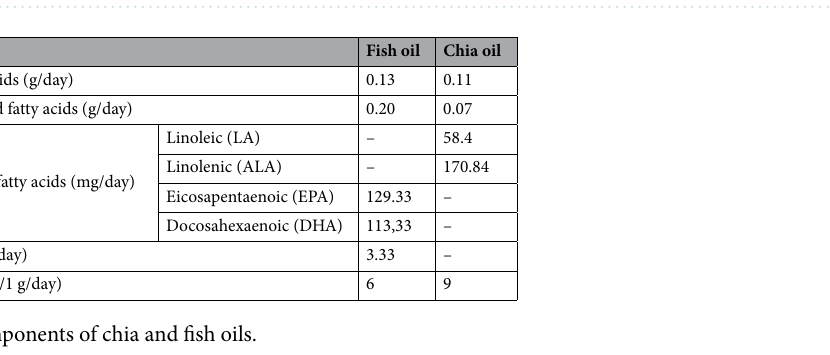
Figure 9. Timeline of intervention protocol for 14 weeks of a high-fat diet, fish oil supplementation, chia oil, and aerobic physical exercise.